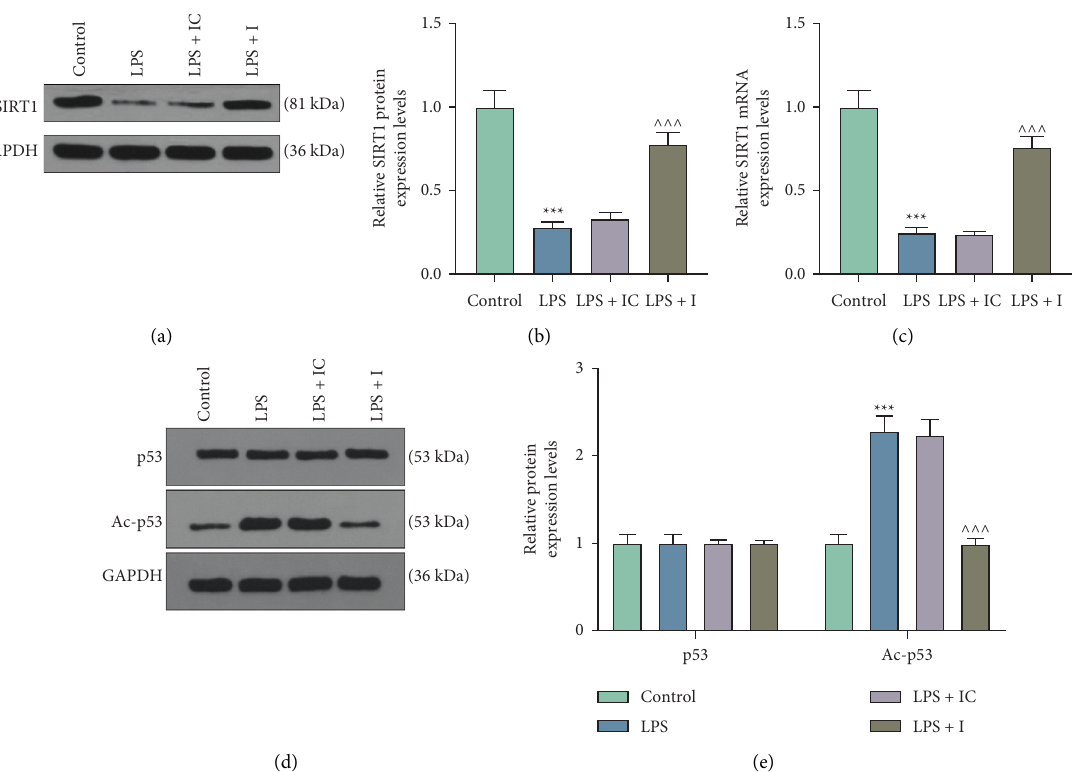
Figure 3: Effects of miR-197 inhibition on the expressions of SIRT1 and p35 in LPS-induced H9C2 cells. (a, b) Western blot was performed to measure the protein level of SIRT1 in LPS-induced H9C2 cells transfected with or without the miR-197 inhibitor. GAPDH was used as the loading control. (c) The mRNA expression of SIRT1 was then determined by qRT-PCR. GAPDH was used as the loading control. (d, e) The protein levels of p53 and AC-p53 in LPS-induced H9C2 cells transfected with or without the miR-197 inhibitor were evaluated via western blot. GAPDH was used as the loading control. ∗∗∗ p < 0 . 001 vs. control; ∧∧∧ p < 0 . 001 vs. LPS+IC. SIRT1, silent information regulator 1; LPS, lipopolysaccharide; qRT-PCR, quantitative real-time polymerase chain reaction; AC-p53, acetyl-p53; GAPDH, glyceraldehyde-3-phosphate dehydrogenase; I, miR-197 inhibitor; IC, inhibitor